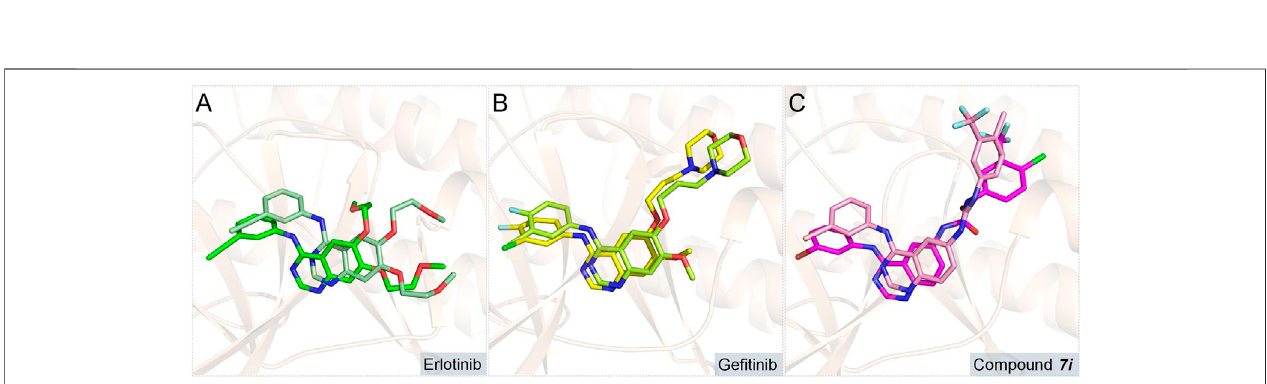
FIGURE 6 | Superimposition of the initial and representative conformations of the three studied systems: (A) erlotinib system (representative conformation is colored in green; initial conformation is marked in pale green); (B) ge fi tinib system (representative conformation is colored in yellow; initial conformation is in limon); (C) Compound 7i system (representative conformation is in magenta; initial conformation is in light-pink).